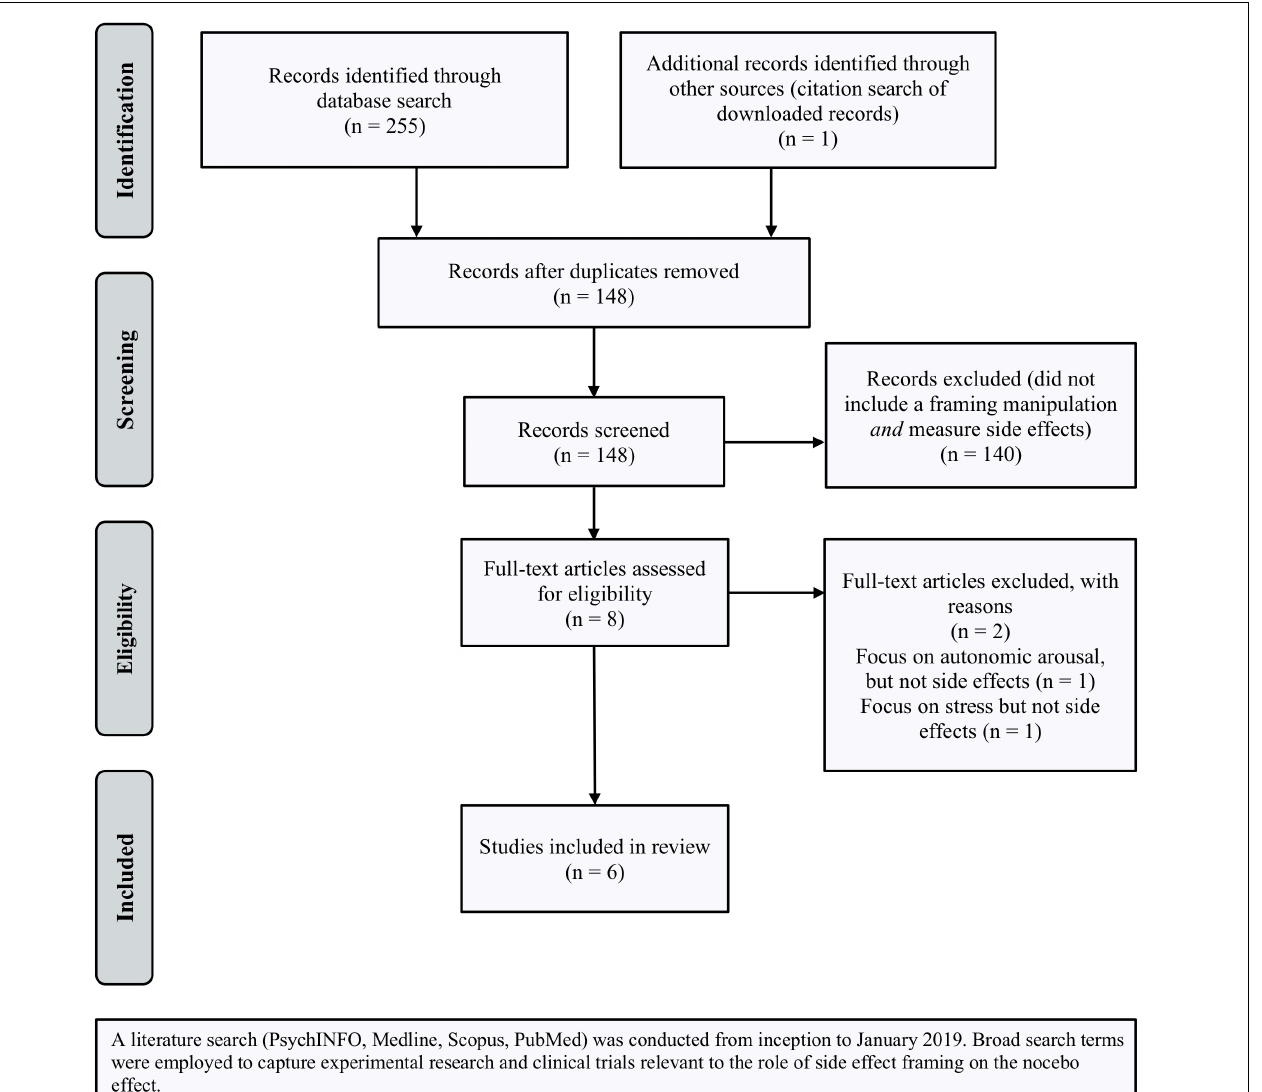
FIGURE 1 | Search terms and PRISMA flow-chart (from: Moher et al., 2009) outlining the procedure used to identify studies included in review.